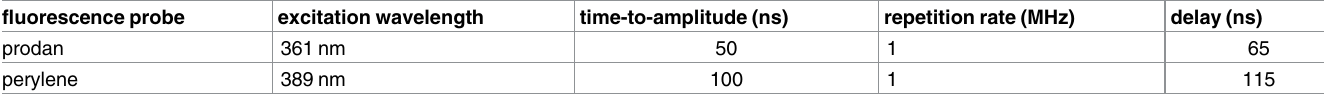
Table 1. Basic instrument parameters for time-resolved fluorescence spectroscopy.